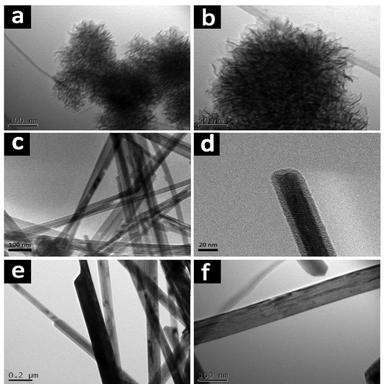
TEM images of (a, b) MnO2 nanosheets, (c, d) MnO2 nanowires and (e, f) MnO2 nanorods templates.